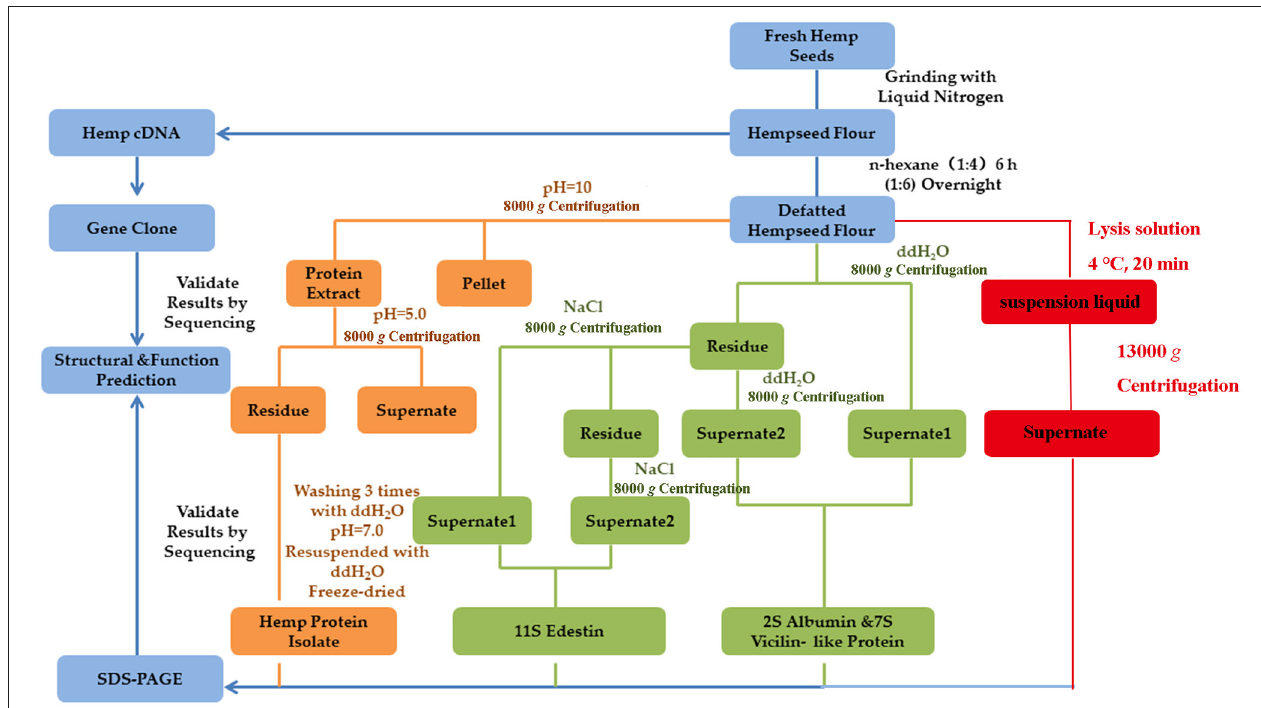
FIGURE 1 | Flowchart of the production of HSP from fresh hemp seeds using different methods. Different colors indicate the different extraction methods; the Osborne method is indicated in GREEN, alkali extraction and acid precipitation method is indicated in YELLOW, protein extraction kit method is indicated in RED, and the common operating steps are indicated in BLUE. The concentration of NaOH and NaCl solutions used was 1M, while the concentration of the HCl solution used was